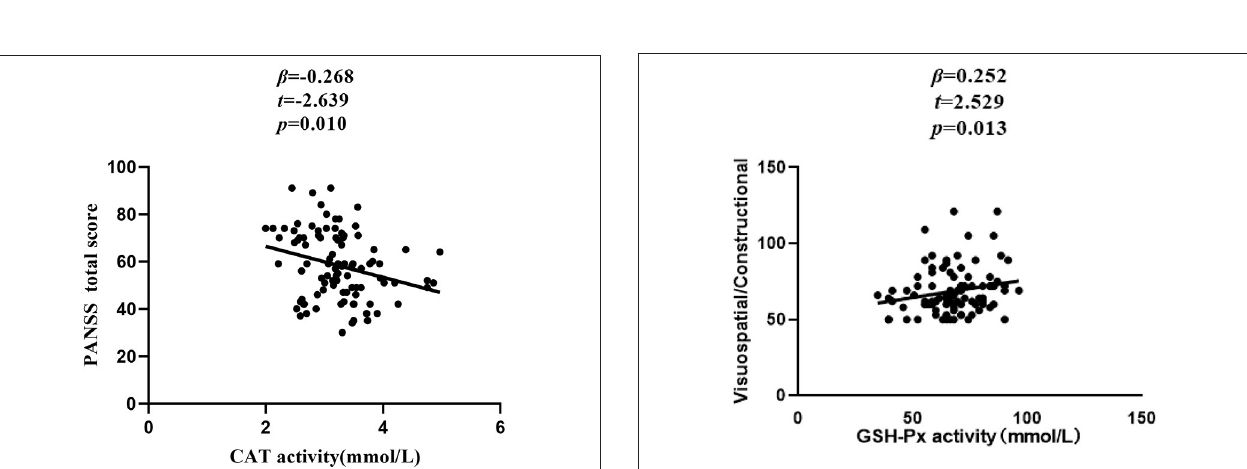
FIGURE 1 | Correlation between CAT activity and PANSS total score in chronic schizophrenia patients.